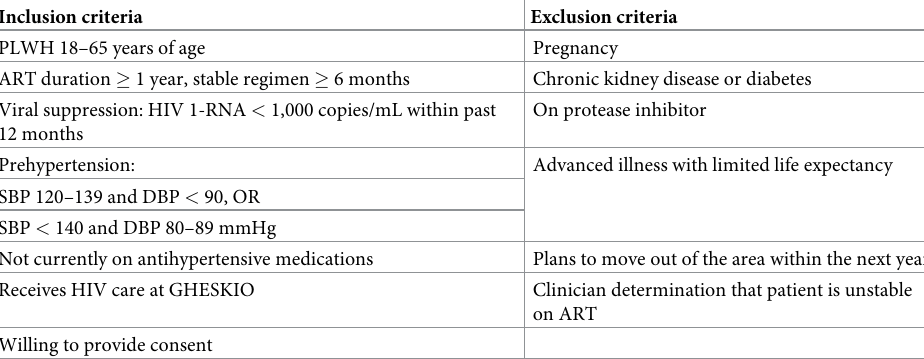
Table 1. Inclusion and exclusion criteria for study